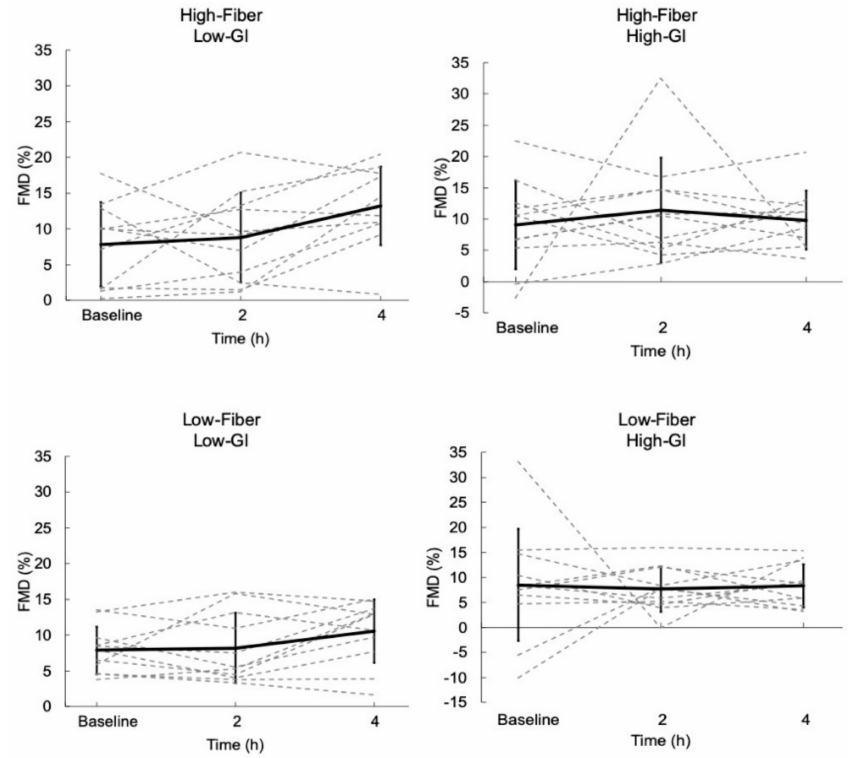
Figure 1. Postprandial change in flow-mediated dilation (FMD) across 4 h for each meal. Dashed lines represent responses for each individual. Solid lines represent mean responses ( ± SD). FMD was not di ff erent across time points for all meals except High-Fiber, Low-GI at 4 h compared to baseline ( p = 0.021; Bonferroni adjusted p =